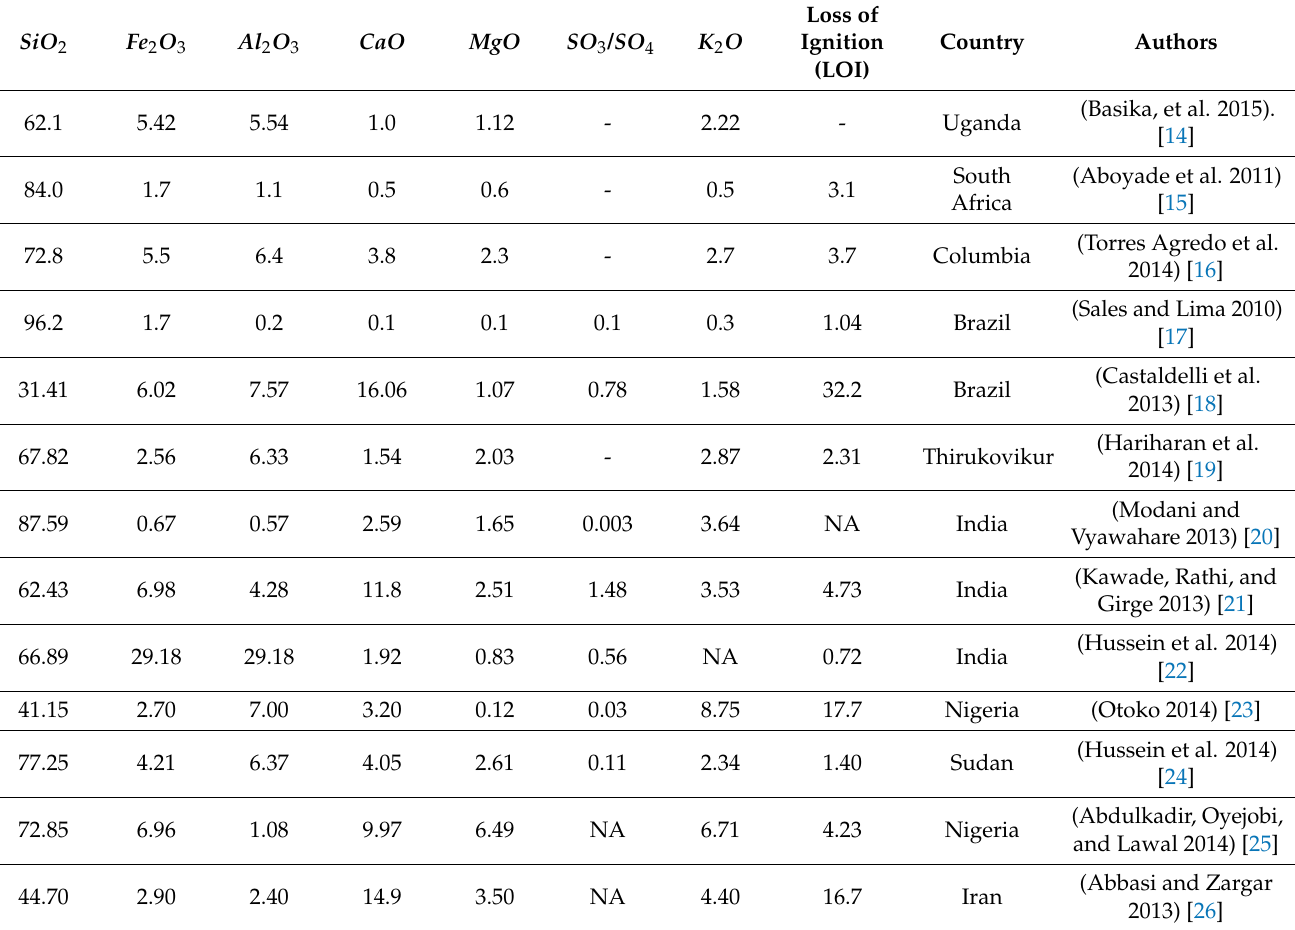
Table 1. Elemental composition (%) of sugarcane bagasse ash from various countries: Analysis and